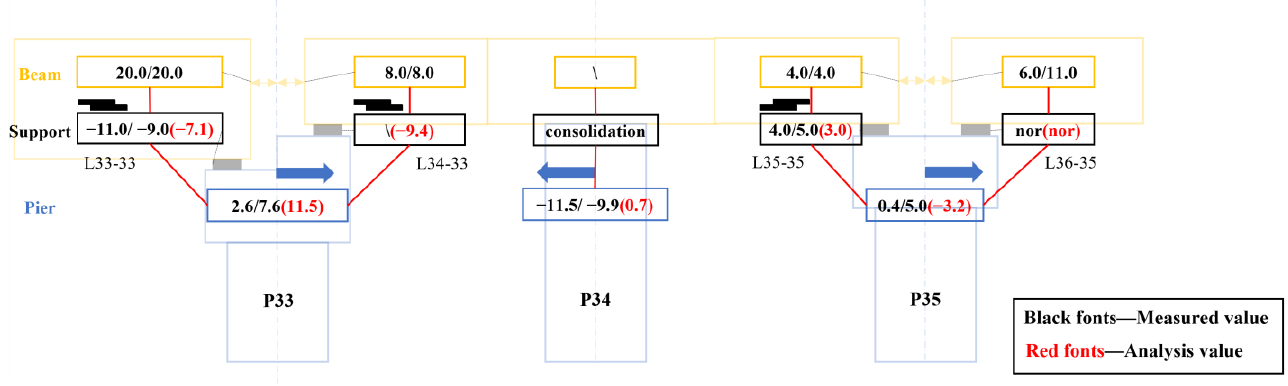
Figure 25. Numerical results and field investigation data between Piers P33 and P35 (cm).